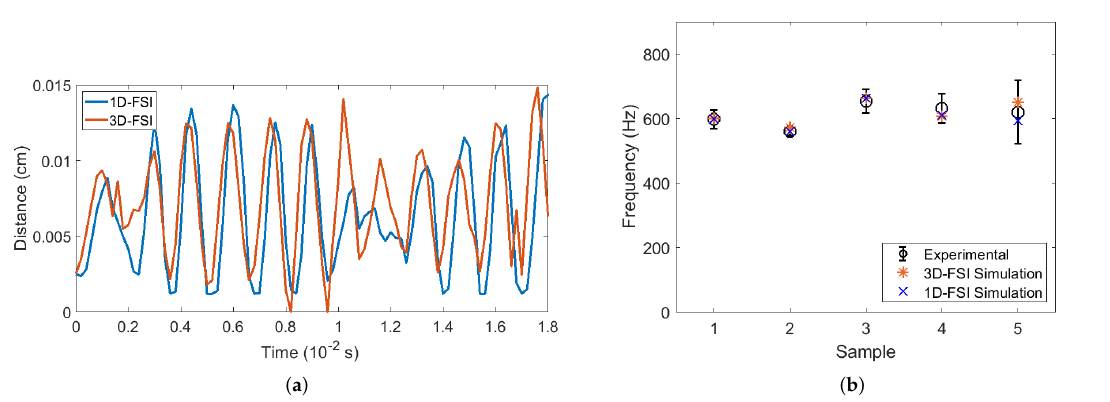
Figure 4. ( a ) VF vibration for Sample 3 plotted for the mid-glottis point in both 1D FSI model (blue line) and 3D FSI model (orange line). ( b ) VF vibration frequency comparison of all five samples among the experiments, 1D-FSI and 3D-FSI